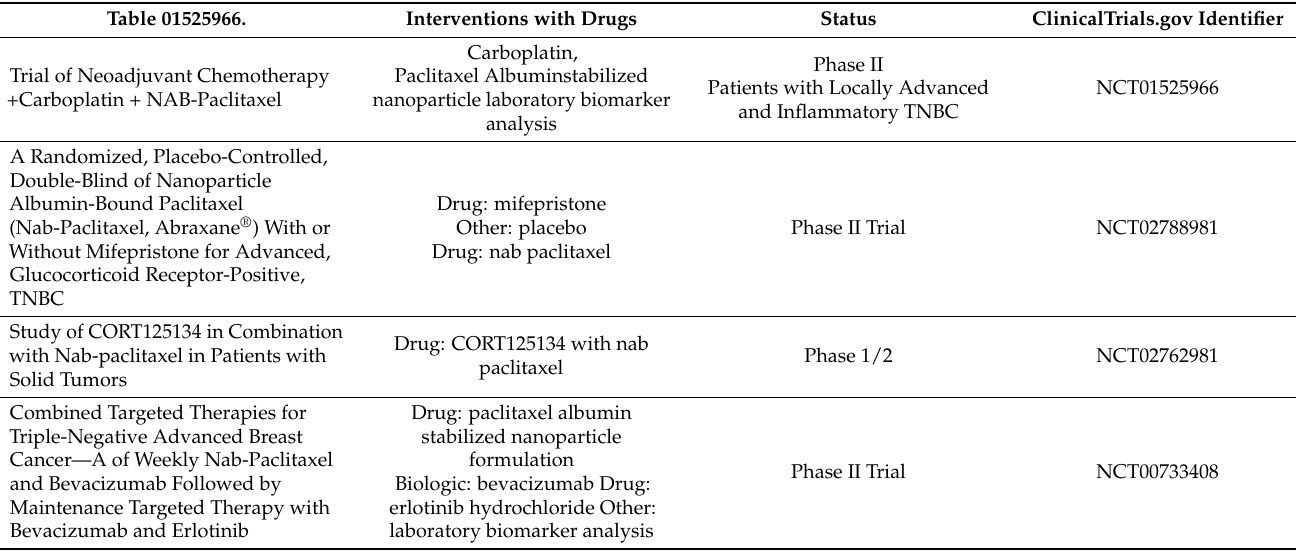
Table 3. Clinical trials in the area of nanotechnology and TNBC. Table